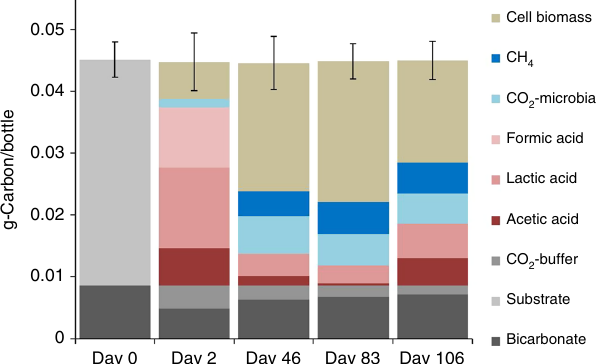
Fig. 8 Carbon balance of six-carbon microcosms at sampling intervals. The sampling intervals are day 2, 46, 83 and 128. The columns represent the cumulative carbon levels of various compounds. Day 0 represents the total carbon (g per bottle) initially added to the system. Data points represent the means ± s.d., n = 3 per group